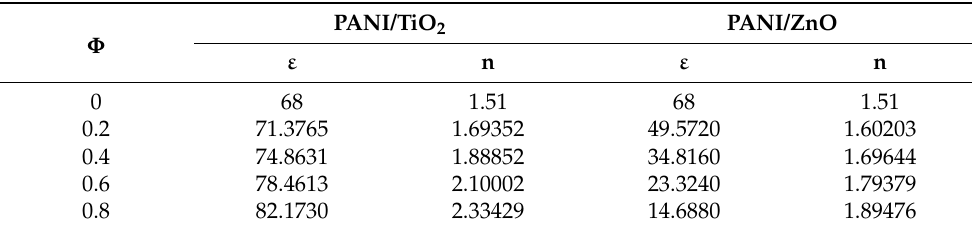
Table 2. The dielectric constant and the refractive index of PANI/NPs as a function of volume fraction Φ of NPs at room temperature (298.15